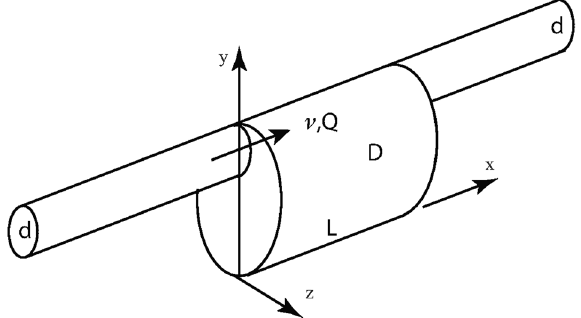
Fig. 2 Drawing of the cylindrical cavity ( d , D , L ) = (0.635 cm, 1.905 cm, 2.54 cm). The flow in the inlet and outlet pipes is along the x -axis, and it is measured on the symmetry, xy